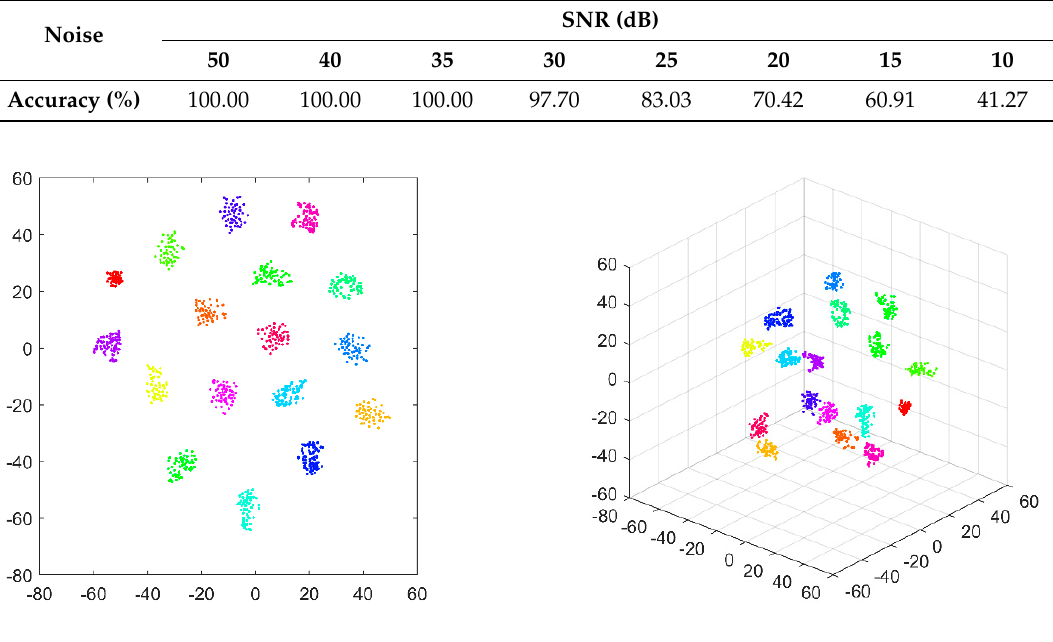
Table 1. Accuracy of damage identification using the transmissibility function (TF)-one-dimensional